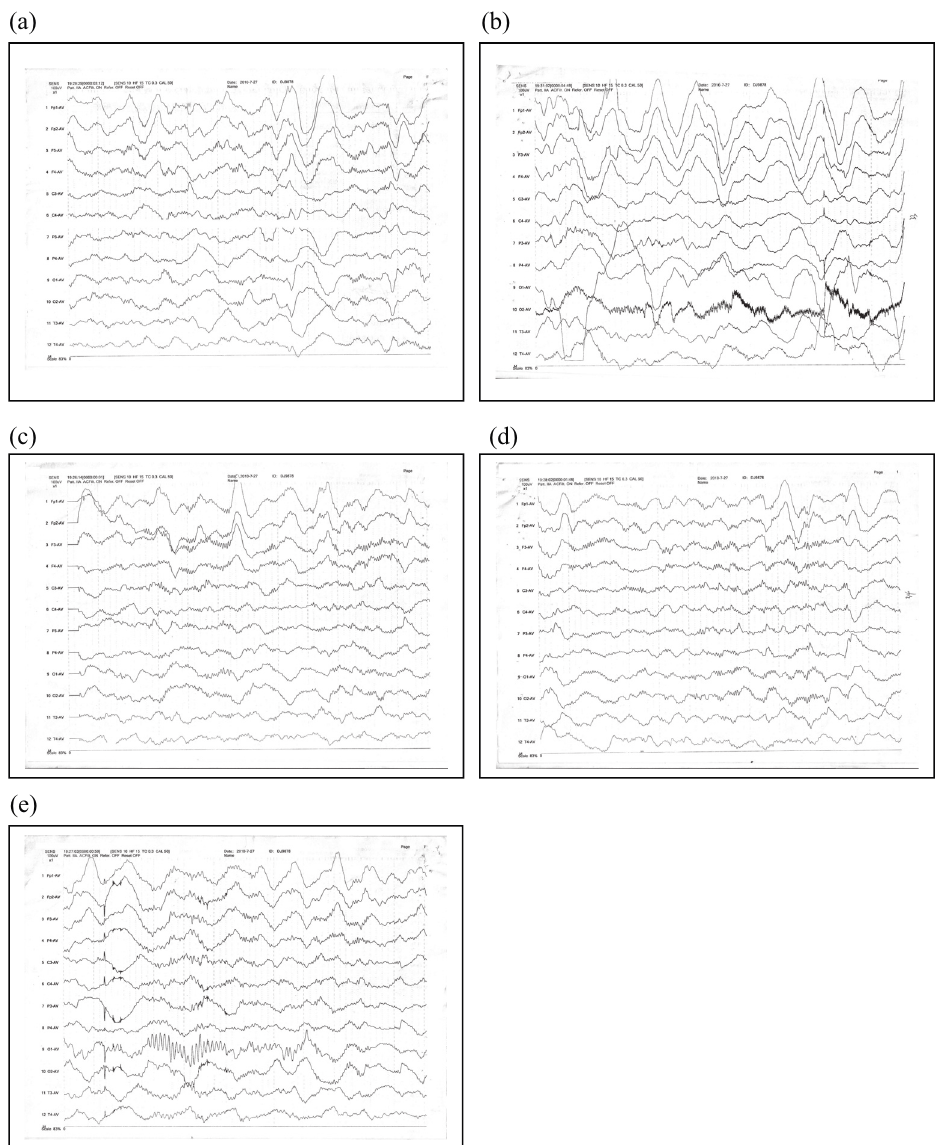
Figure 1. Representative EEG segments of the child immediately after she was transferred into the intensive care unit. A, Coma. B, Stimulation. C, Coma with sedative. D, Sleeping. E,